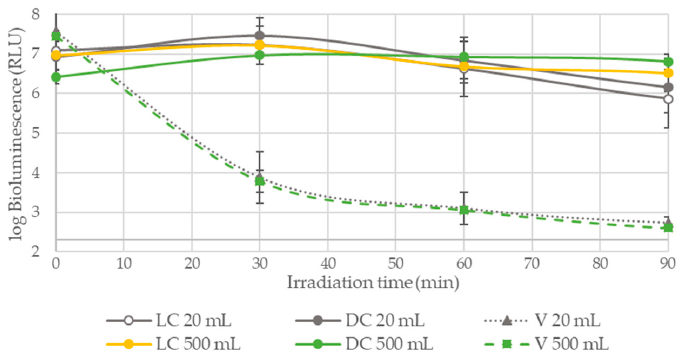
Figure 4. E. coli inactivation in WW with different total volume of medium suspension. Tetra-Py + -Me was used at a concentration of 10 µM, and the samples were irradiated with white light (380–700 nm) with an irradiance of 40 W m − 2 for 90 min. Legend: light control (LC), dark control (DC), and samples with different volumes (V). Values represent the mean of three independent experiments with two replicates each. XX axis cross the YY axis at 2.30 log RLU, representing the detection limit of the